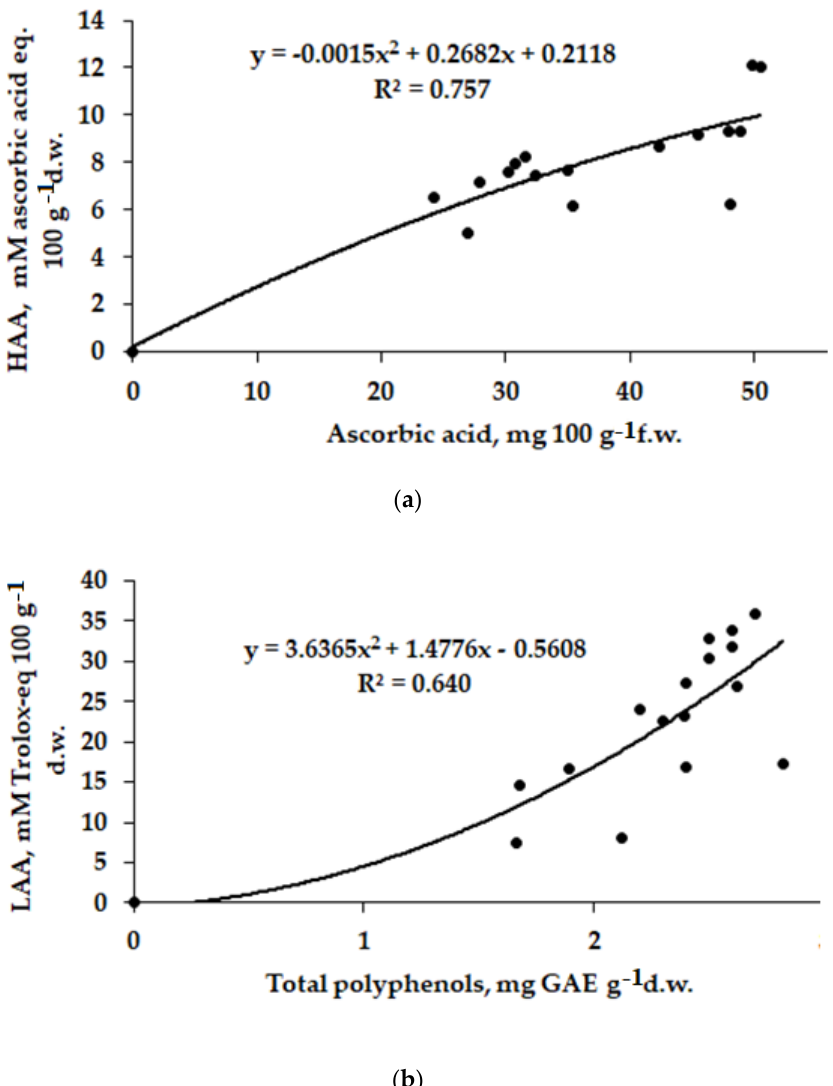
Figure 3. Correlation between ( a ) HAA and ascorbic acid content (r = 0.870, p < 0.001) and ( b ) LAA and polyhenols (r = 0.800, p < 0.001) in tomato fruits.